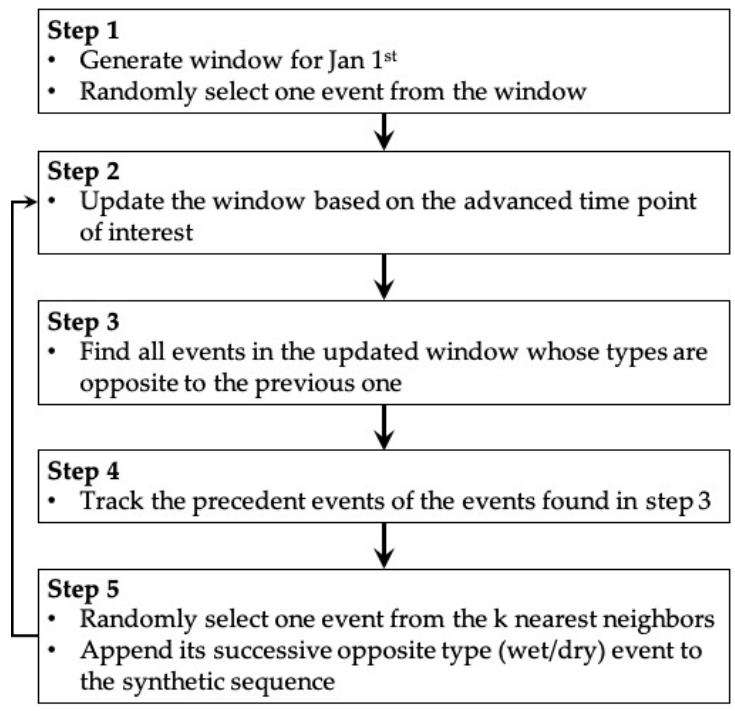
Figure 2. Non-parametric stochastic generator flow chart.